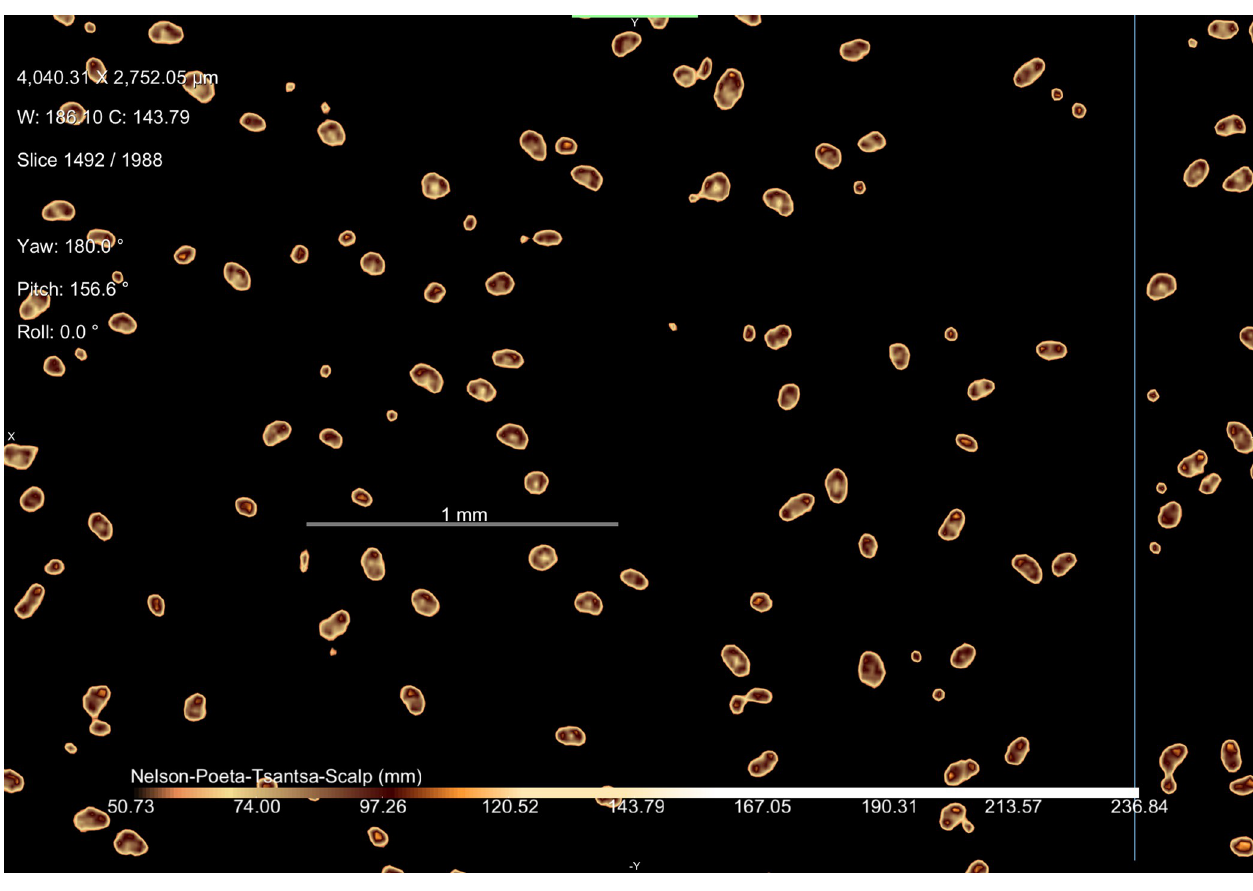
Fig 10. High resolution micro-CT slice through the hair shafts of the tsantsa